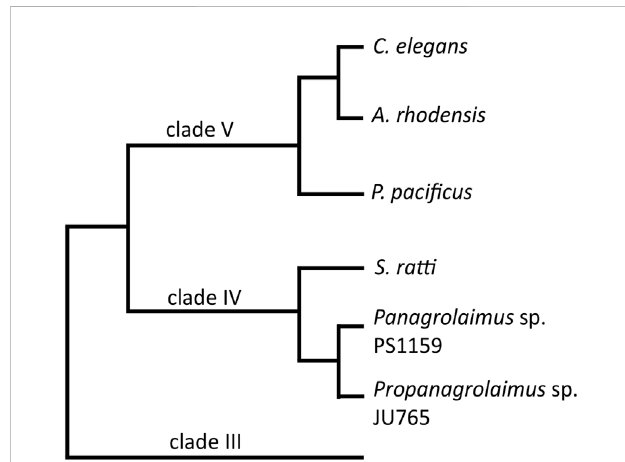
FIGURE 1 A cladogram showing the position of the two main species in this study, Panagrolaimus sp. PS1159 and Propanagrolaimus sp. JU765, in relation to the nematode model organisms C. elegans and P. paci fi cus , as well as A. rhodensis and S. ratti , species with reportedly successful use of the CRISPR system (modi fi ed from Blaxter and Koutsovoulos, 2015; Tandonnet et al.,